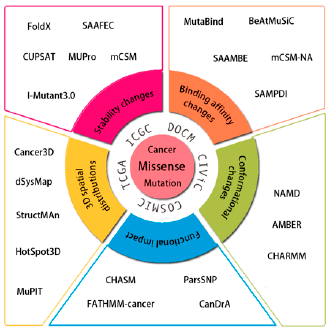
Figure 1. Overview of computational approaches and tools for identifying cancer driver missense mutations. Each method or tool was assigned to one of the five categories.